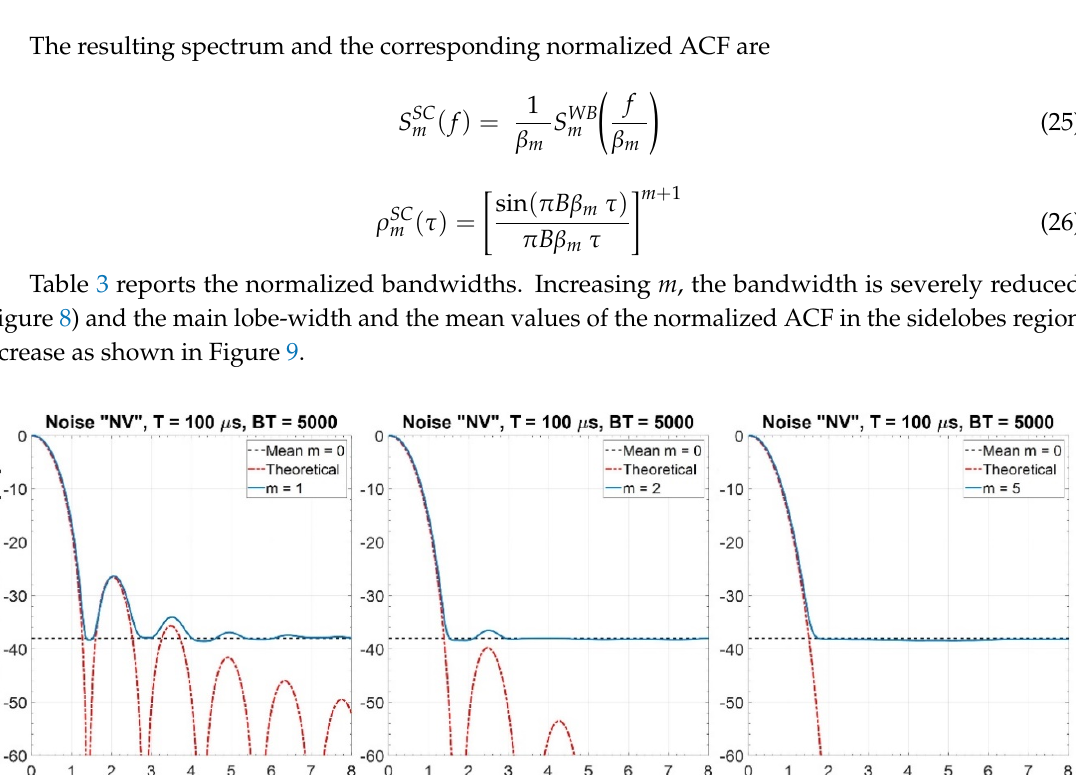
Table 3. Normalized bandwidth ( − 3, − 6, − 10, and − 20 dB) of the spectrum for “SC” waveforms. “SC” Waveforms m B − 3 /B B − 6 /B